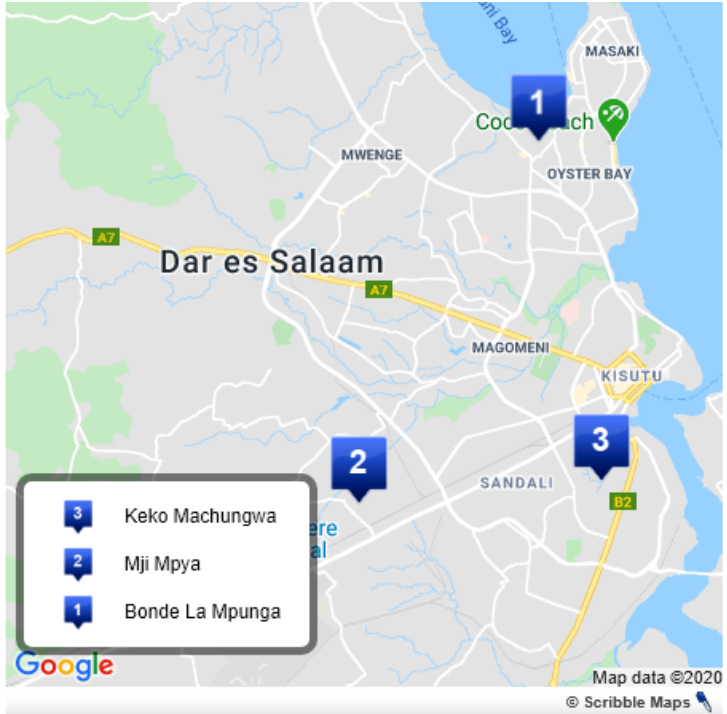
Figure 4. Map of Dar es Salaam, showing selected study sites. Source: Authors. Urban Planning, 2020, Volume 5, Issue 3, Pages